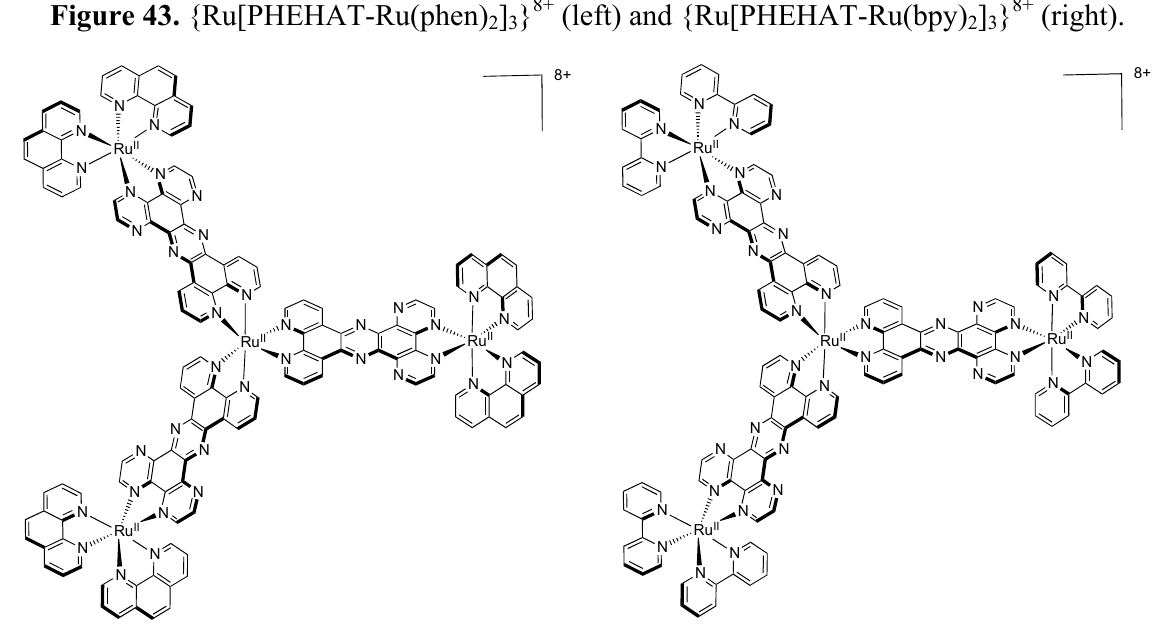
Figure 43. {Ru[PHEHAT-Ru(phen)